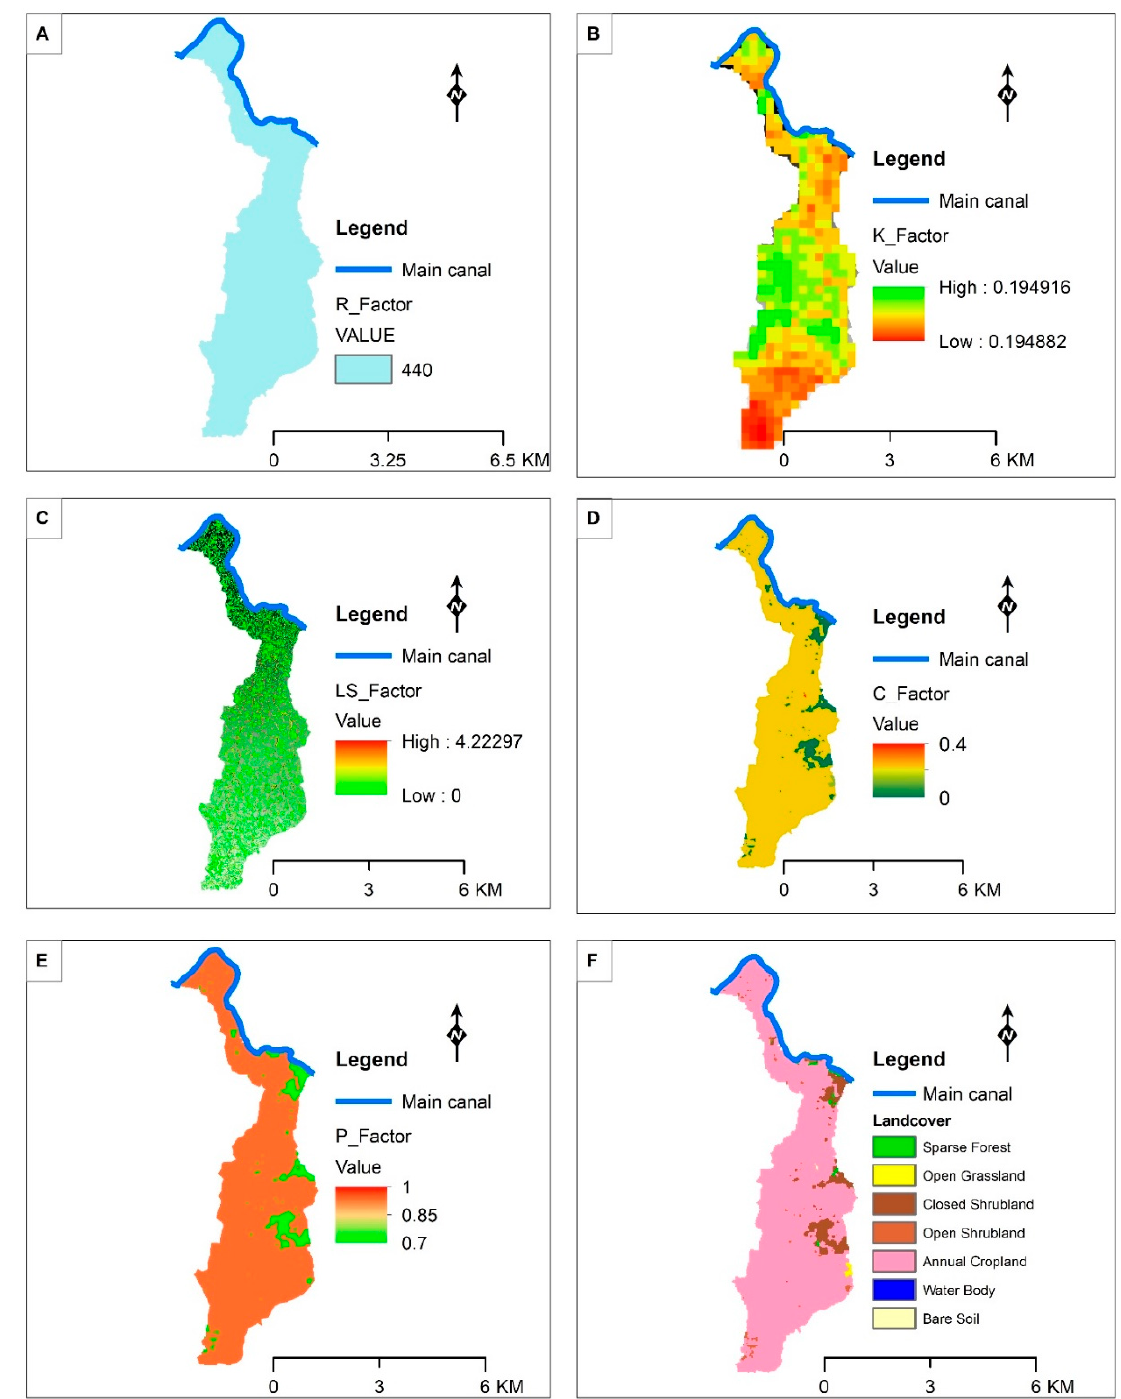
Figure 7. Raster maps of catchment contributing overland sediment inflow to the main canal of the Ketar scheme. ( A – E ) depict factors of the revised universal soil loss equation. ( A ): Mean annual soil loss (R factor); ( B ): soil erodibility (K factor); ( C ): slope length and steepness (LS factor); ( D ): land cover and management (C factor); ( E ): support practices (P factor). ( F ): Maps land cover in the study area.